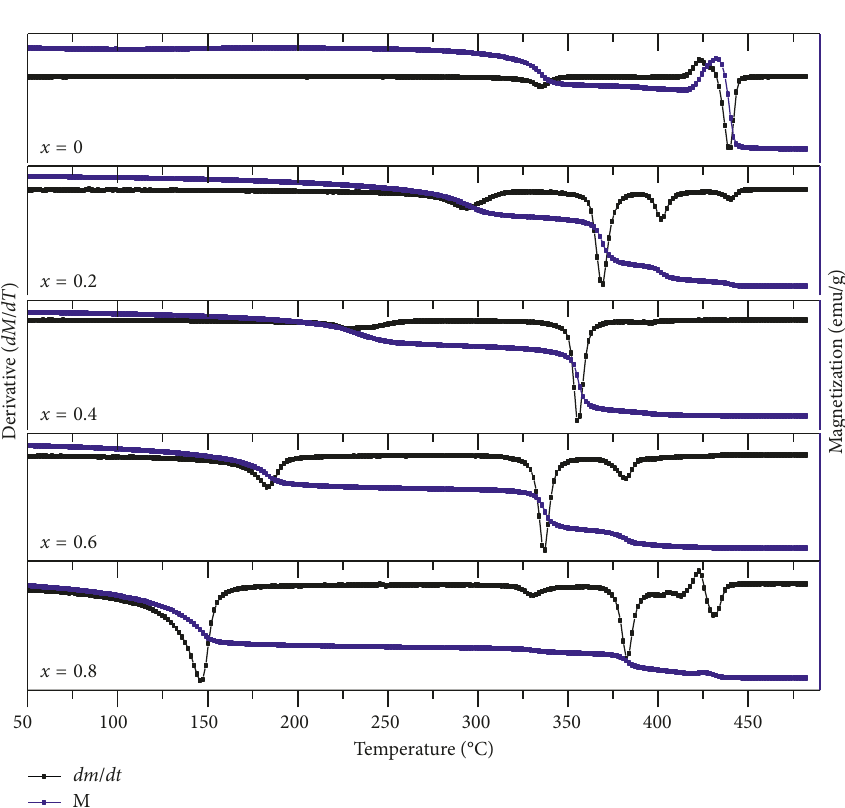
3 [Cu 0.8 − x Zn x Mn 0.2 ] 2 Fe 24 O 41 .